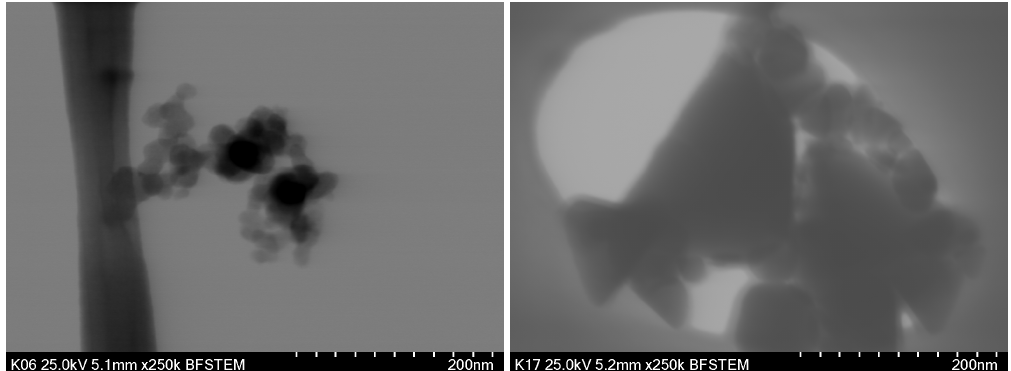
Figure 5. STEM images of the 25% Mg content samples: KA2 ( left ) and KB2 ( right